Question: State the chart type depicted above.
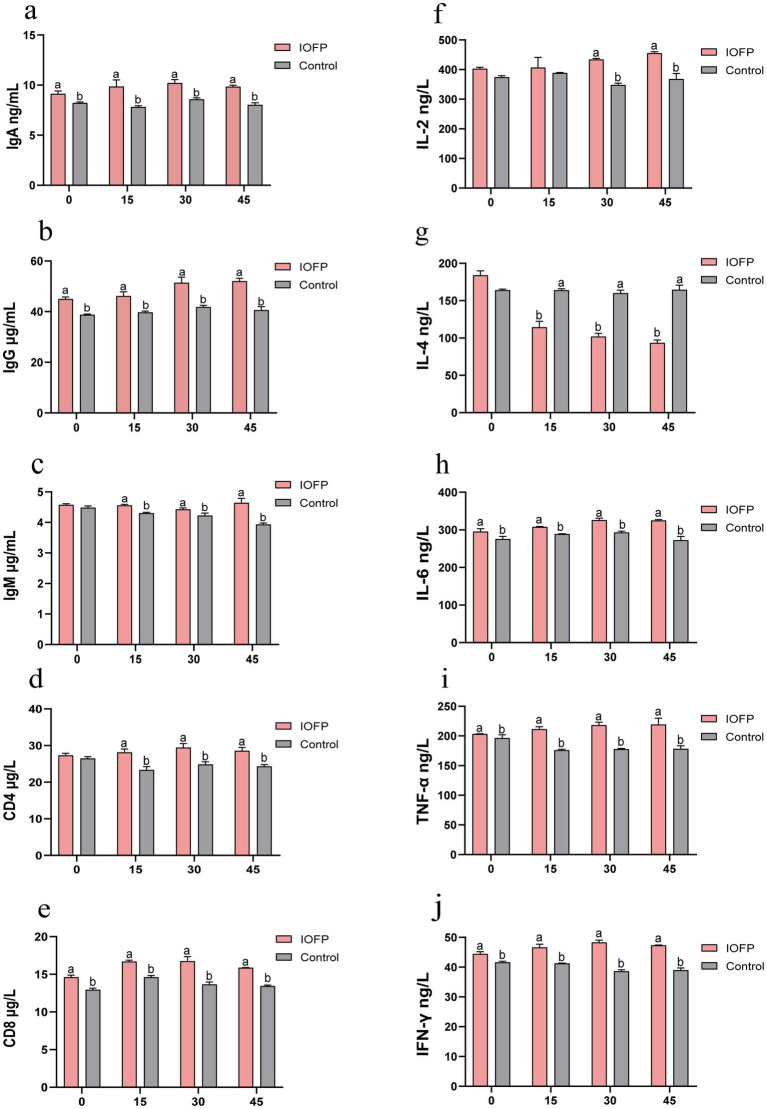
Answer: bar